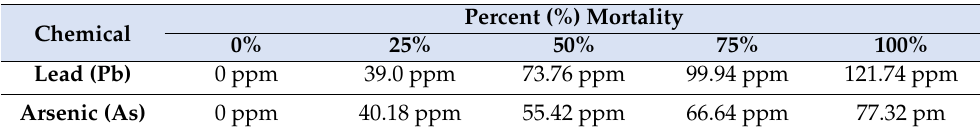
Table 2. Lethal concentrations of single metal exposure to arsenic (As) or lead (Pb) at 120 h post fertilization (hpf) in parts per million (ppm, mg/L).